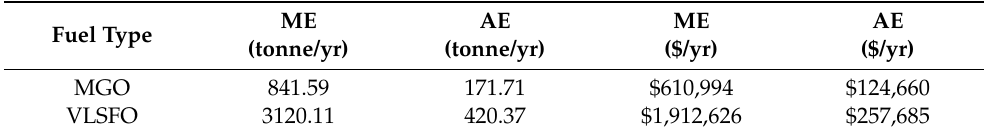
Table 4. Fuel consumption and costs between